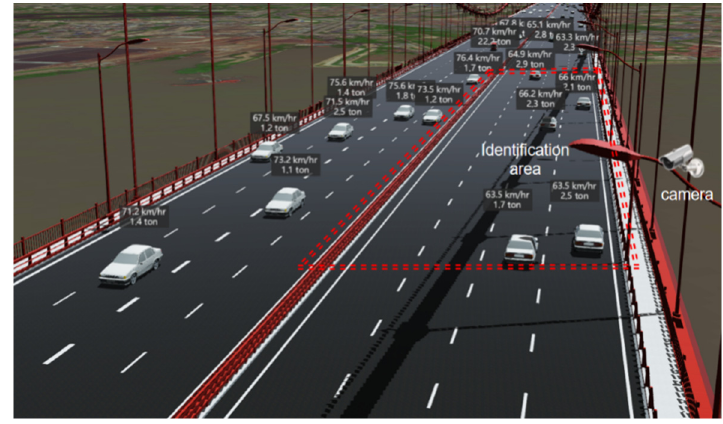
Figure 2. On-site hardware layout.